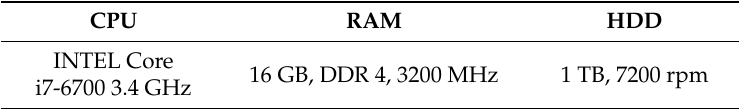
Table 1. Characteristics of working machines